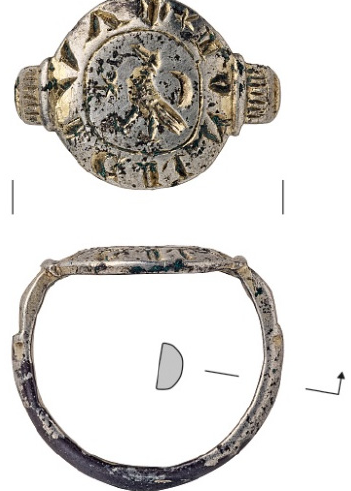
Figure 7. Treasure from Wiener Neustadt. Finger ring with “striding bird” motif, 13th/14th century. Photo: Paul Kolp; editing: Franz Siegmeth.